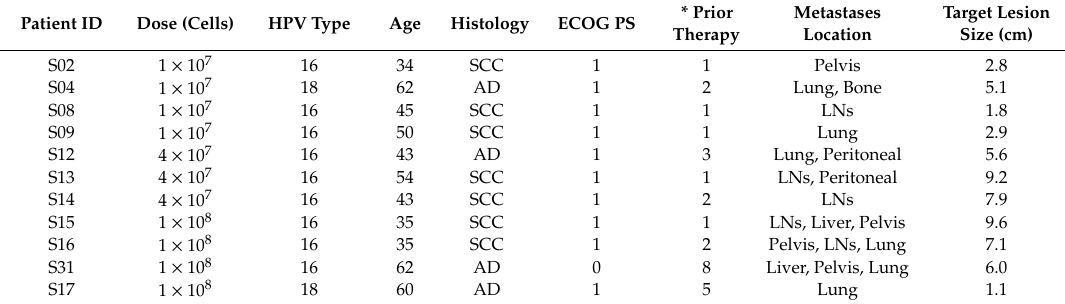
Table 1. Patient characteristics.